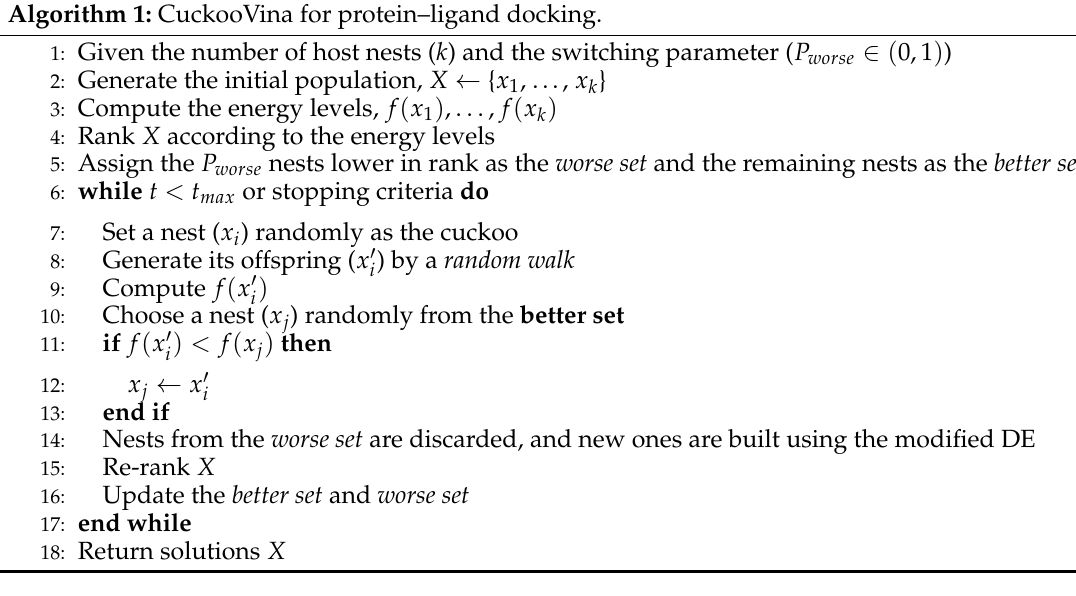
Algorithm 2: Modified DE for mutating a nest ( x w ) in the worse set